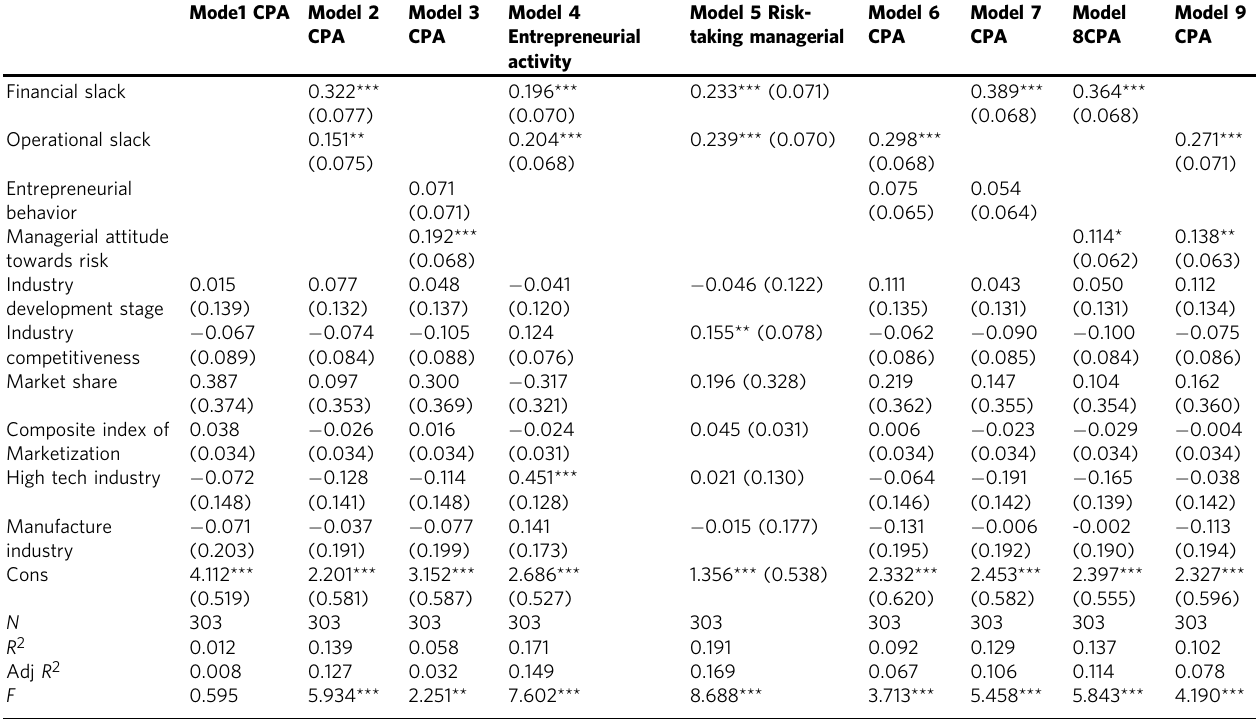
Table 4 Results for hypotheses testing.